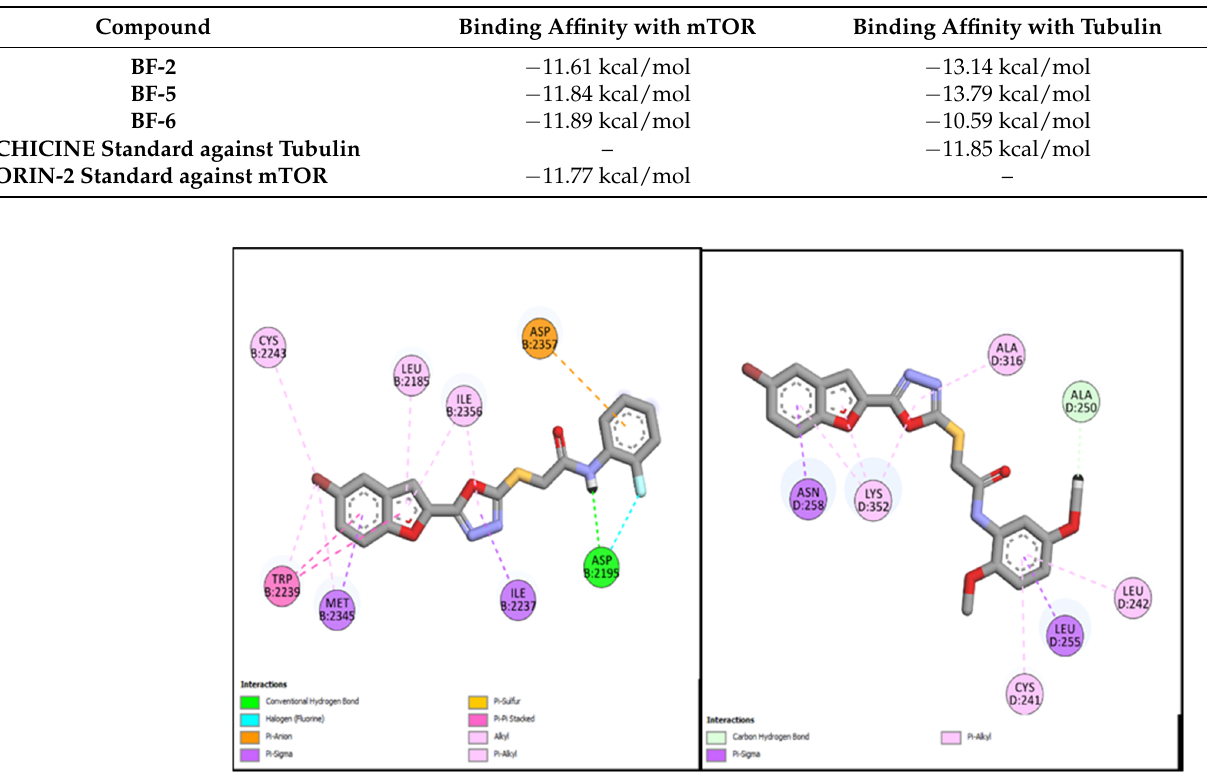
Figure 9. Two-dimensional interactive poses of BF-6 with mTOR (Left) and BF-5 with Tubulin (Right) in its active (Right) in its active sites. Table 5. Binding affinities of BF-2, BF-5, and BF-6 with mTOR and Tubulin.